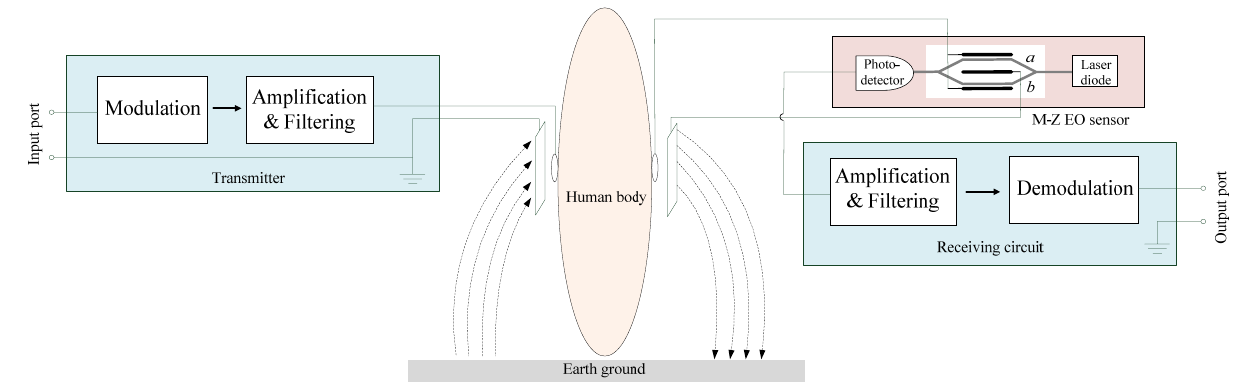
Figure 1. The developed signal transmission system based on the human body